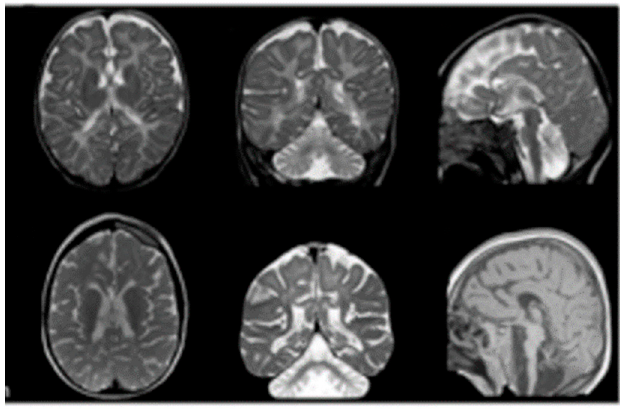
Figure 1. Magnetic resonance imaging. Images are 1.5 to 3 T and include T1-weighted, T2-weighted and fluid-attenuated inversion recovery (FLAIR) sequences. Structural abnormalities include cerebellar and brainstem atrophy, dilated ventricles and subarachnoid spaces, thinning of the corpus callosum and hypomyelination.